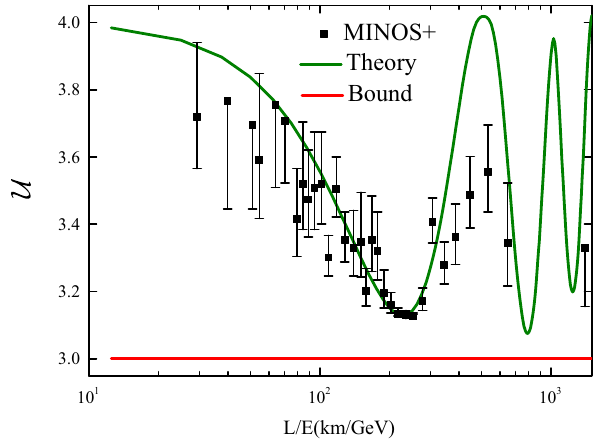
Fig. 6 The total entropic uncertainty ( U ) as a function of L / E with an initial muon flavor state. The green line represents the theoretical total entropic uncertainty in Eq. (35); The red line represents the bound of EUR in Eq. (18), the black squares stand for the experiment data from MINOS+ collaboration [6]